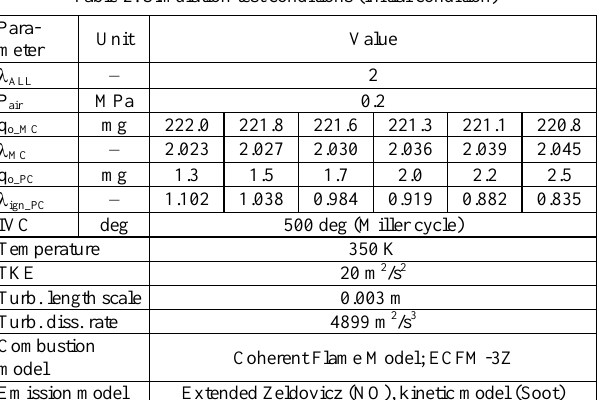
Table 2. Simulation test conditions (initial condition)